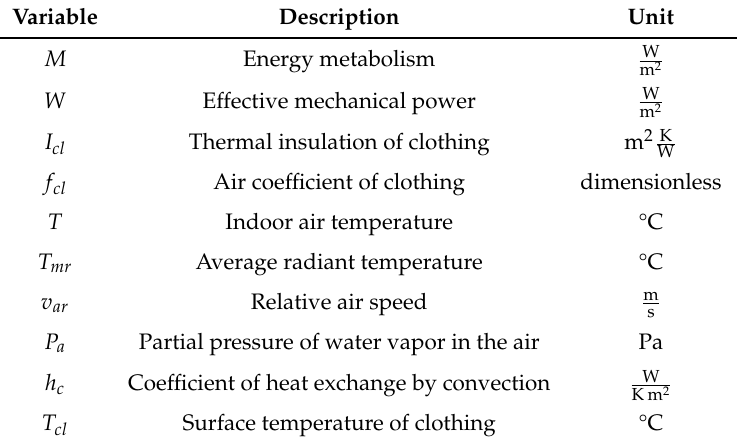
Table 1. Variables and parameters influencing the PMV